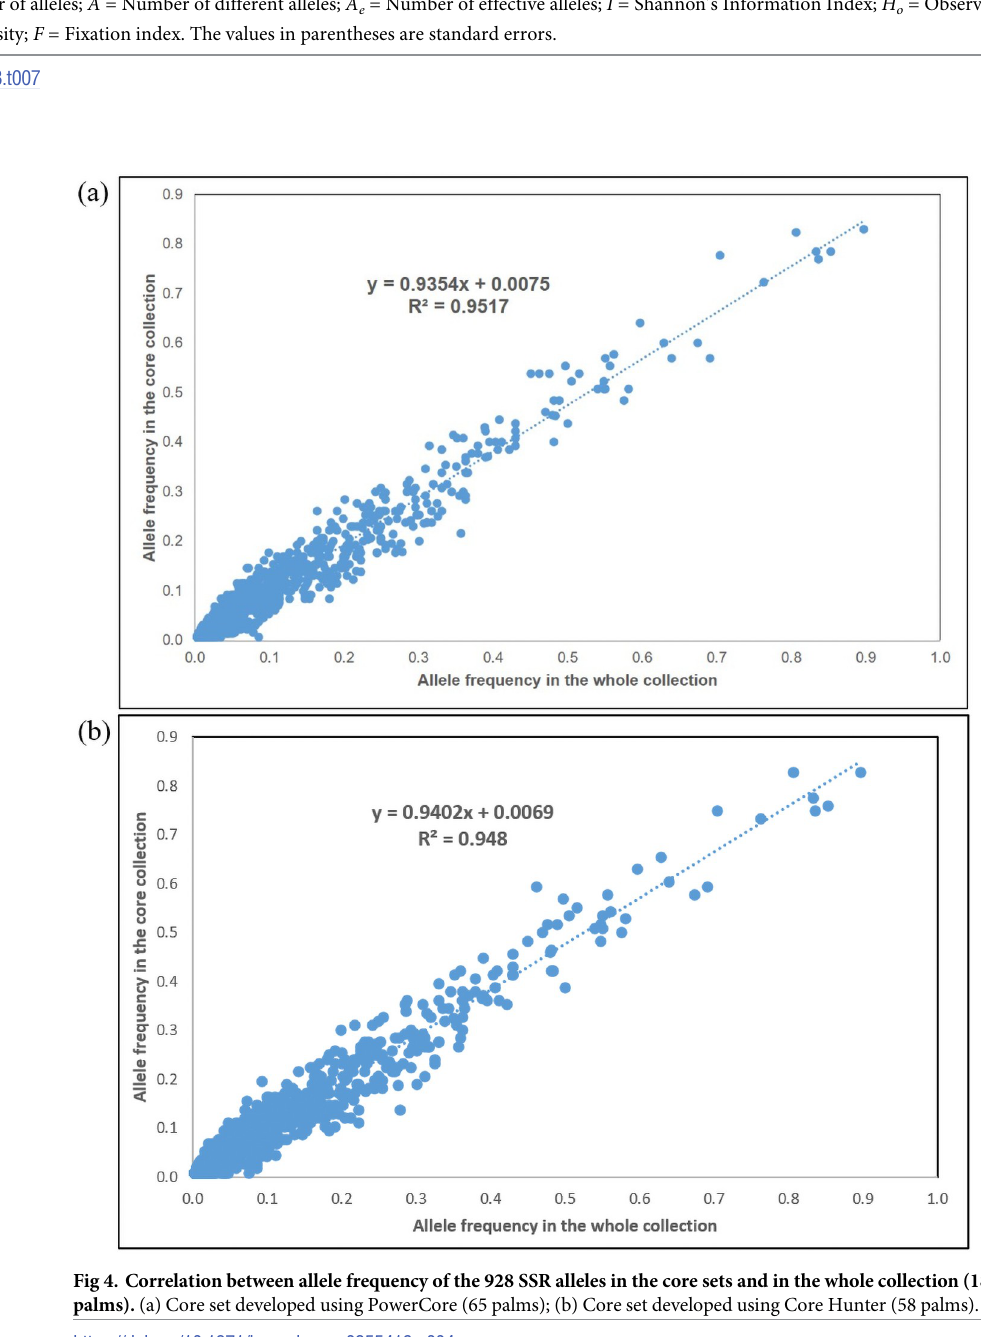
PLOS ONE | https://doi.org/10.1371/journal.pone.0255418 July 29,